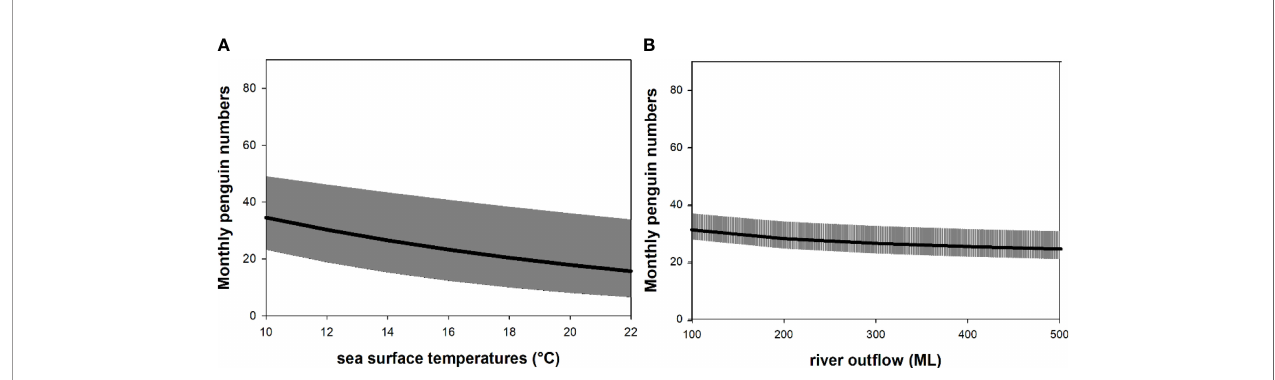
FIGURE 5 | Relationship between the monthly average little penguin numbers on Granite Island (South Australia) and (A) sea surface temperatures (°C) and (B) river out fl ow (ML). Each plot represents the effect of a single predictor on the monthly number of little penguins assuming all other predictors remain constant. The slope of the relationship is represented by the black line; shaded areas indicate 95% con fi dence intervals.